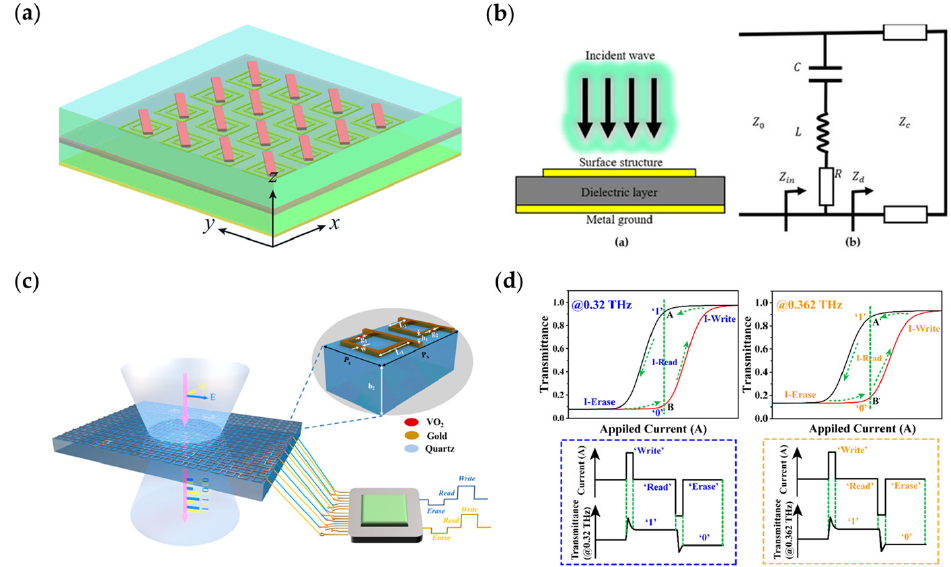
Figure 2. ( a ) Reconfigurable metasurface loaded with VO2 material, the metal–insulator–metal structure forms a resonant cavity. Reprinted with permission from [164], copyright © 2000–2023 by John Wiley and Sons, Inc. or related companies. All rights reserved; ( b ) VO2-based metasurface absorber and its equivalent circuit; ( c ) A novel dual-channel storage device; ( d ) Phase transfor-